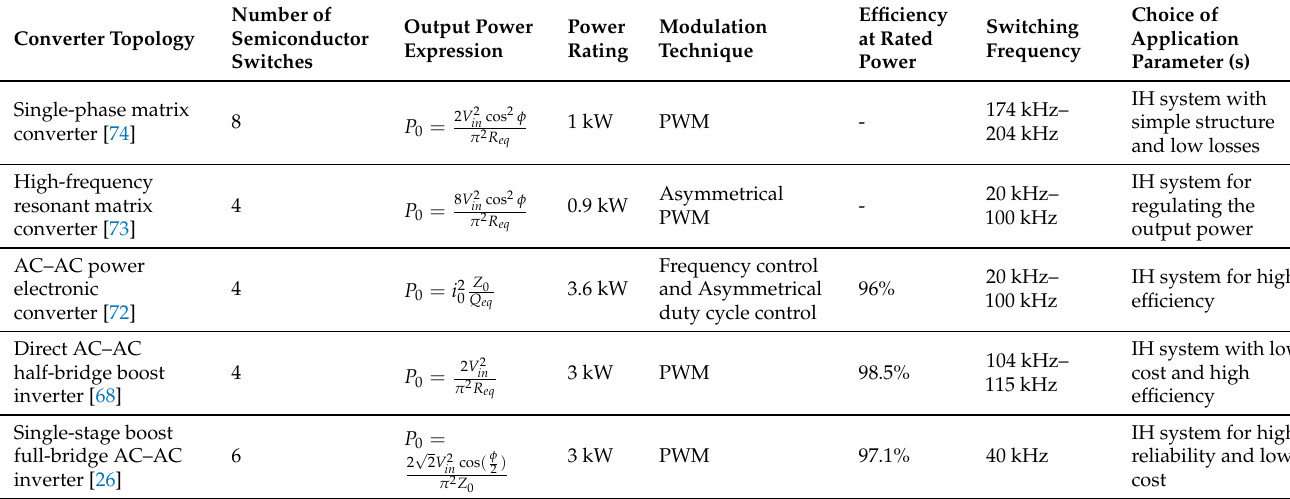
Table 4. Summary of various parameters in direct AC–AC VSI-fed IH